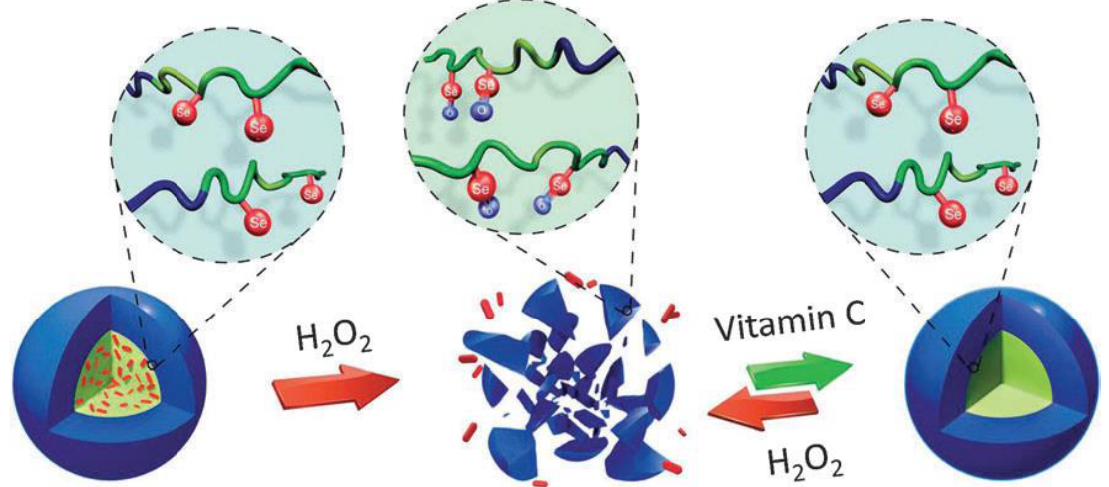
Figure 3. Schematic illustration showing redox-responsive assembly and disassembly of selenium (in red color) functionalized poly(ethylene glycol-poly(acrylic acid) (PEG-b-PAA) polymers [21]. Reprinted from Ren et al. [21], with permission from The Royal Society of Chemistry. Copyright (2012) The Royal Society of Chemistry.